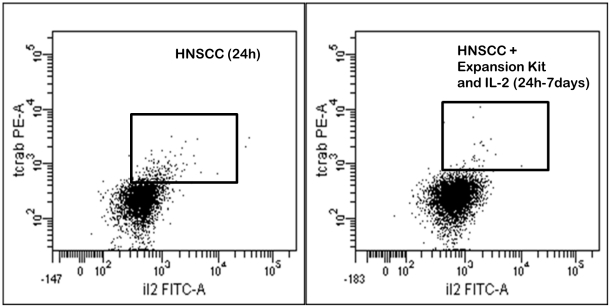
We incubated isolated CD123+ BDCA-2+ HLA-DR+ cells with HNSCC and the T cell Expansion Kit (Miltenyi) in addition to IL-2 (20-200 U/l) for 3-7 days.Less TCR-αβ+ cells were revealed (after 1-7 days) when compared to the control with HNSCC after 24 h. Presumably this can be attributed to the down-regulation of the TCR subsequent to cell activation.